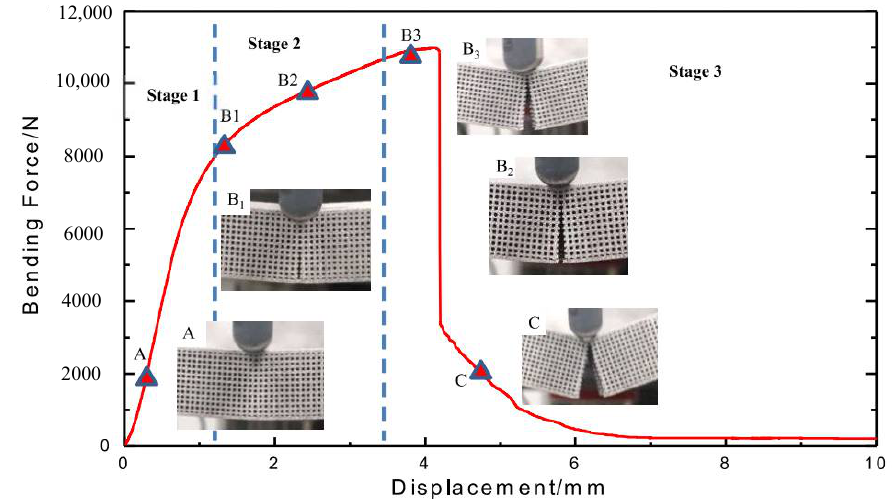
Figure 8. Different stages of specimen bending .